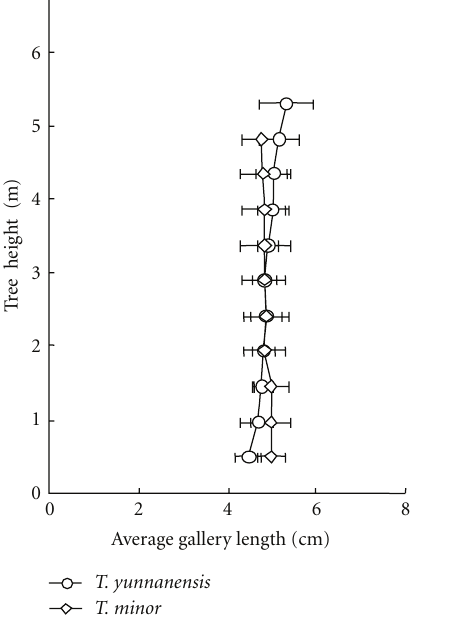
Figure 7: Average egg gallery length ( ± SE) of T. yunnanensis and T. minor along the trunks Yunnan pines in January, 2006 (Qujing, Yunnan province, China).